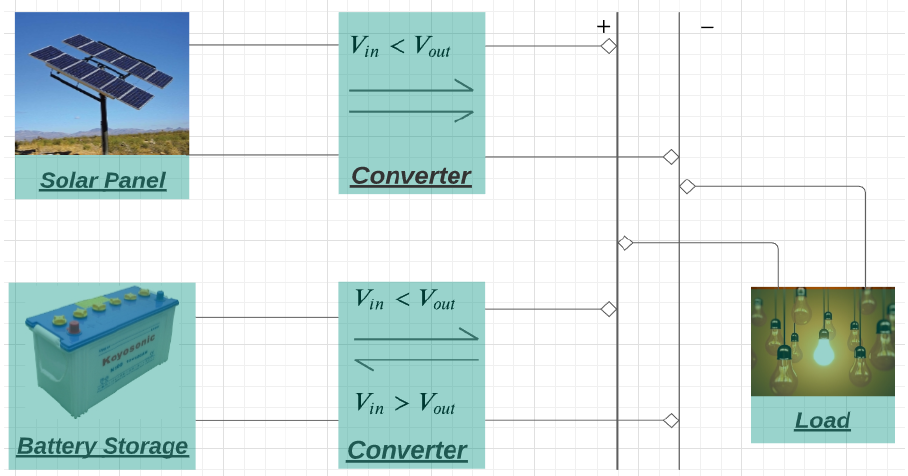
Figure 1. Typical view of a standalone hybrid PV-BES